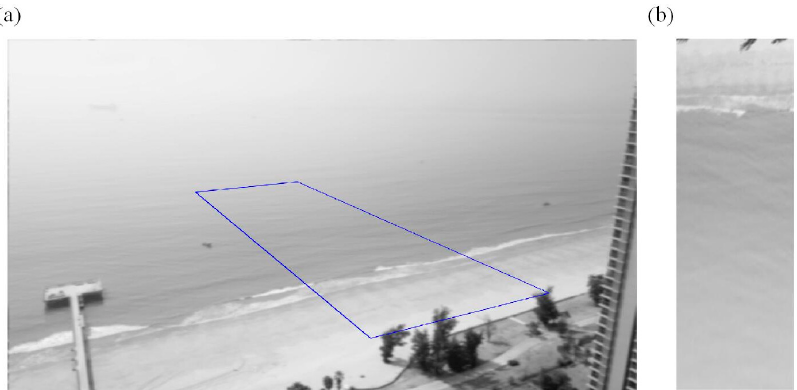
Figure 7. Background identification. The green points are marked as background points, while the red points are marked as foreground points. All steps are shown in Figure 8 for a single UAV. We chose a GCP as the origin of the world coordinate system and determined the pixel area corresponding to the whole ROI. Table 2 demonstrates the configuration of orthoimages.